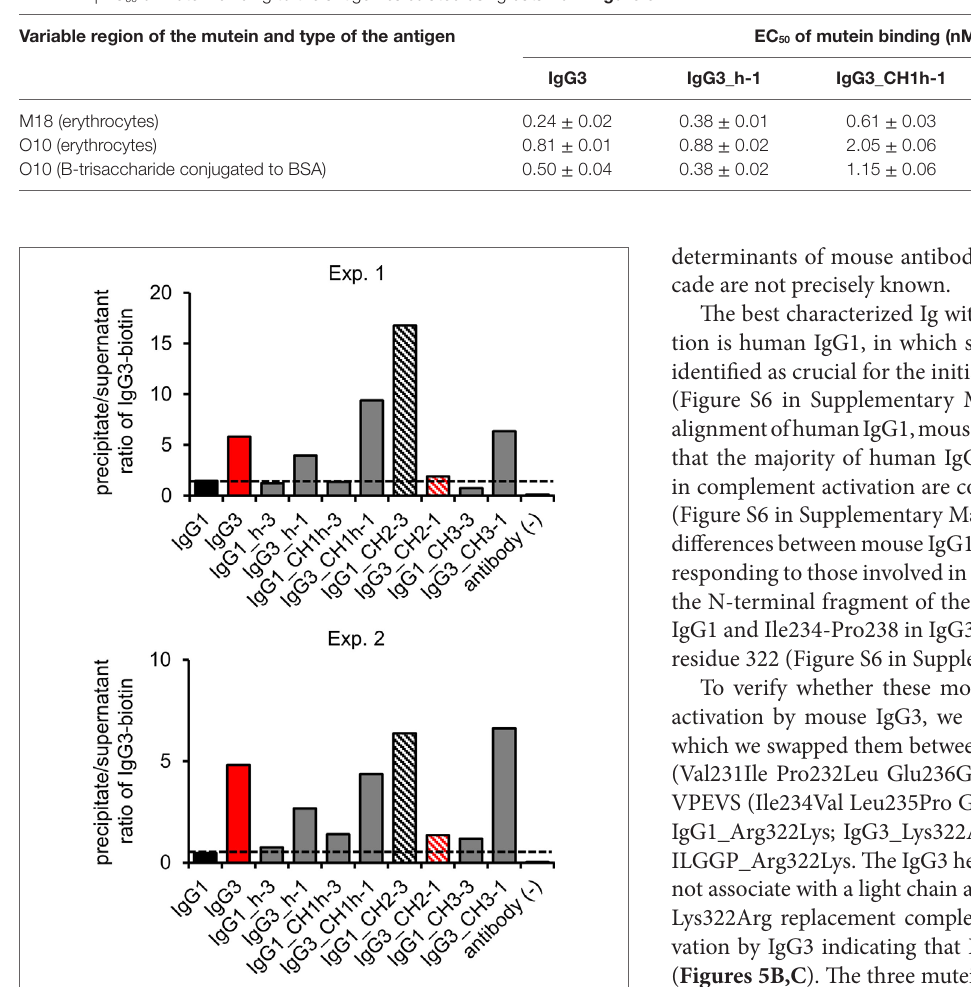
FigUre 4 | Oligomerization of the domain muteins. The antibodies (M18 variants, 150 µg/ml) were incubated at 4°C and oligomers were precipitated using PEG. Biotinylated IgG3 was used as a probe that oligomerized with the muteins and became a part of the complexes. The charts present results from two independent experiments. The results obtained for 100 and 20 µg/ ml of the muteins are shown in Figure S3 in Supplementary Material. A percentage of the total IgG3-biotin detected in the precipitates and the supernatants is presented in Figure S4 in Supplementary Material.